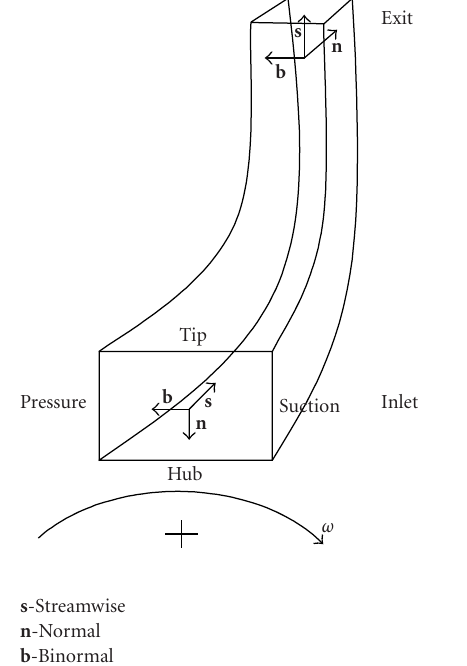
Figure 1: Intrinsic coordinate system in centrifugal